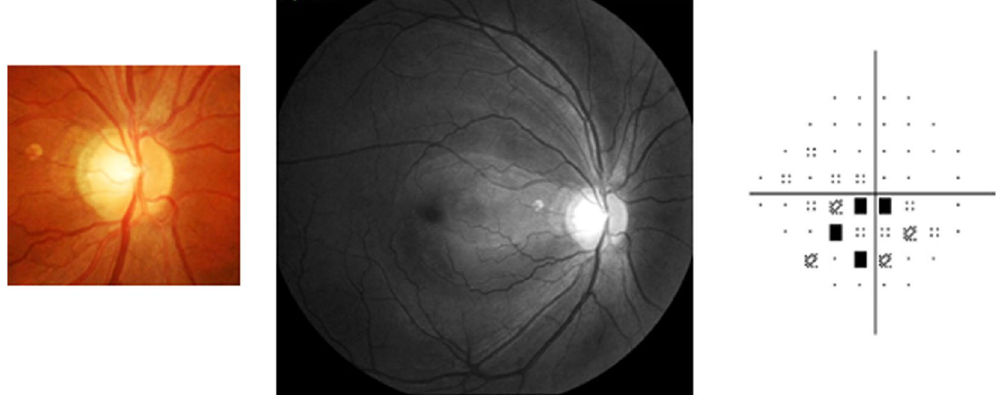
Figure 3. A Representative case with multiple retinal nerve fiber layer (RNFL) defects. A 47-year-old man with a history of systemic hypertension showed multiple RNFL defects in his left eye. His visual field damage also involved paracentral